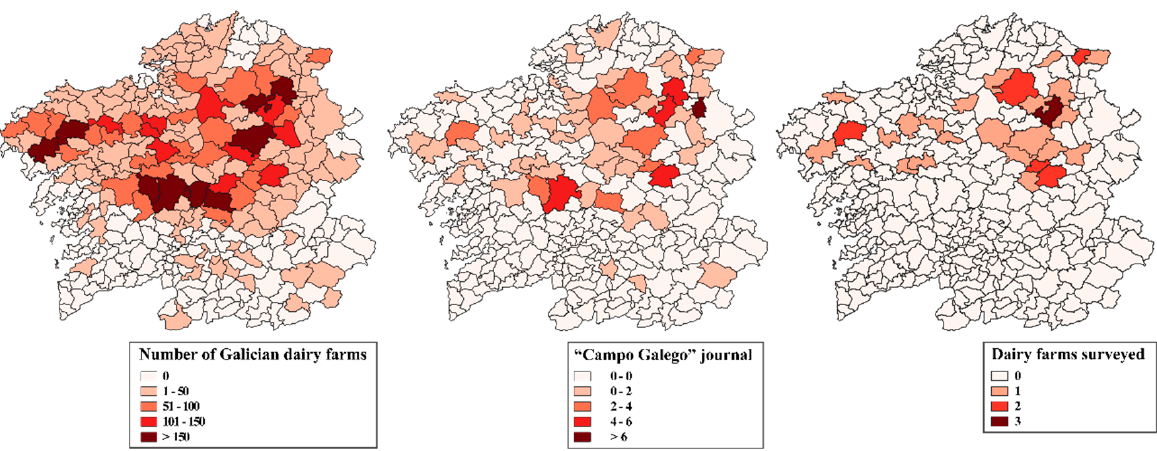
Figure 2. Galician dairy farms.